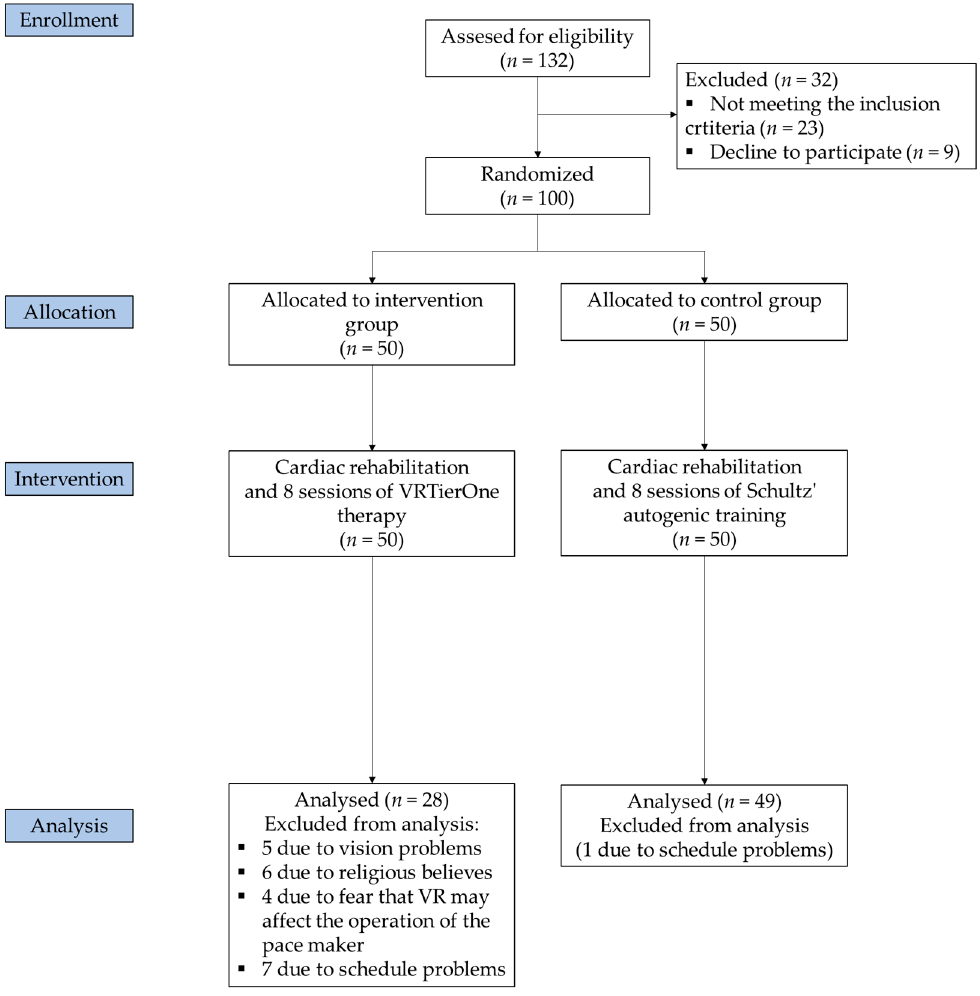
Figure 1. Study flow diagram. Table 1. Participants’ baseline